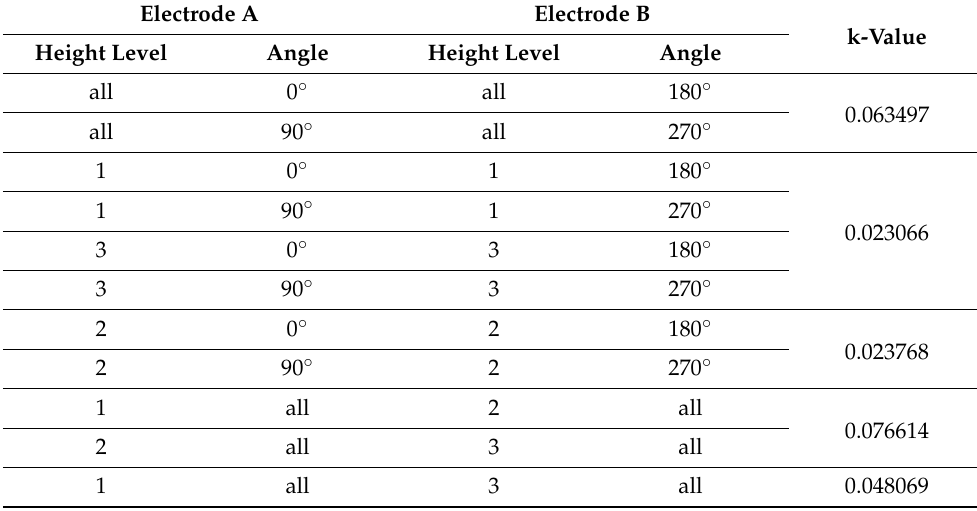
Table A2. Geometry factors k for the drilling core analysis, calculated by Comsol with an electrode array with angular distances of 90 ◦ and electrical resistivity of the electrodes in the Comsol model of concrete: 100 Ω